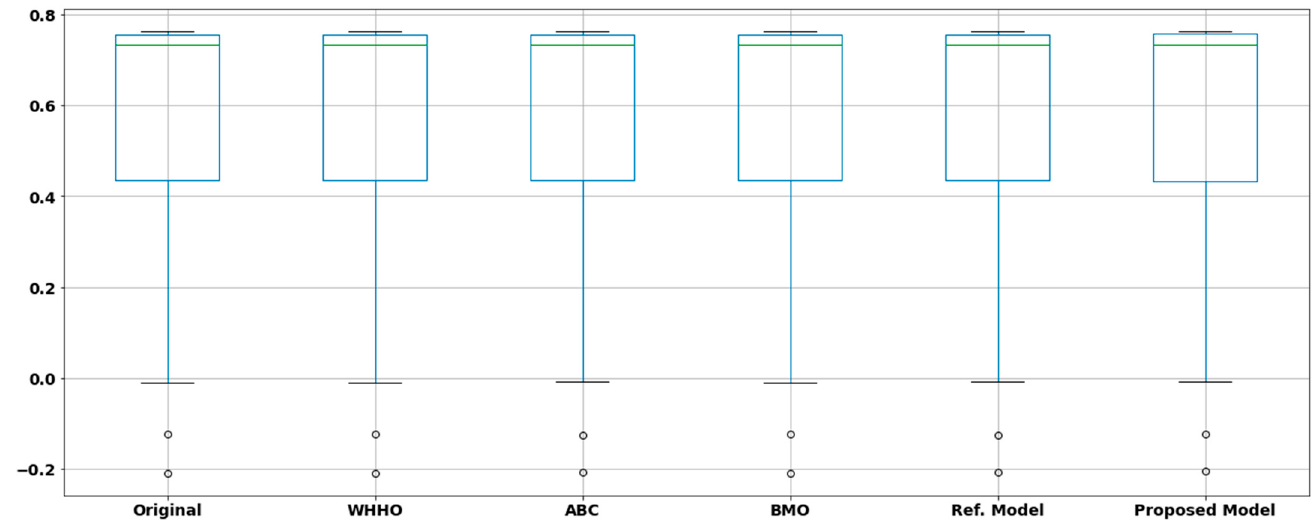
Figure 8. Boxplot of the current variation of the original data, proposed model, and other models from the literature (WHHO [14], ABC [36], and BMO [38]) regarding the R.T.C. France model.